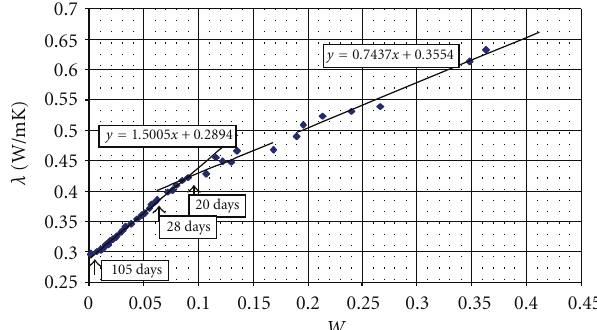
Figure 14: Evolution of the thermal conductivity ( λ ) versus water content ( W ) of the lime-hemp concrete during its setting and har-